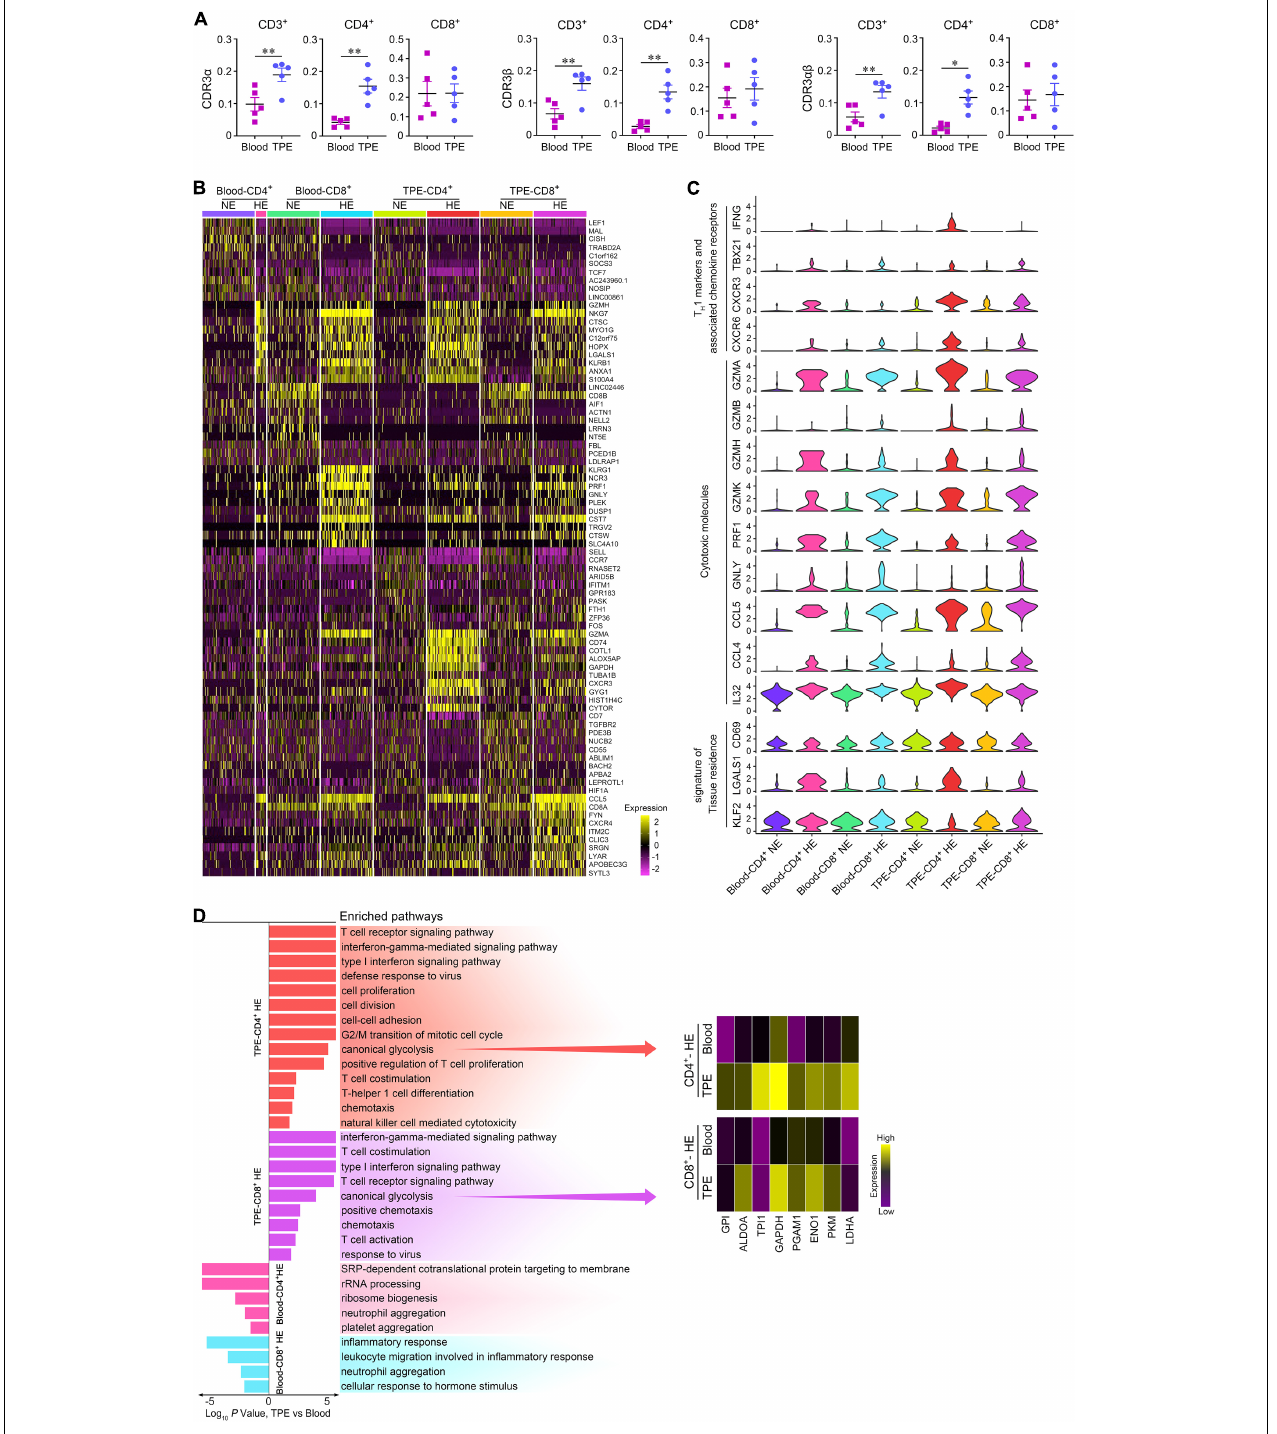
FIGURE 4 | Comparisons of enriched and non-enriched T cell subsets in human TPE and blood. (A) Enriched CDR3 aa clonotype frequency comparisons on CD3 + , CD4 + , and CD8 + T cells between TPE and blood. (B) A heatmap comparing the top 10 differentially expressed genes in each highly enriched and non-enriched T cell subsets in 200 randomly sampled cells per cluster, excluding 39 highly enriched CD4 + T cells in blood. HE, highly enrichment; NE, non-enrichment. (C) Violin plots of expression for select genes in each highly enriched and non-enriched T cell subsets in 200 randomly sampled cells per cluster, excluding 39 highly enriched CD4 + T cells in blood. (D) Pathway enrichment identified immune response pathways for highly enriched T cell subsets between TPE and blood. Data are presented as means ± SEM. * P < 0.05, ** P < 0.01, determined by paired t test. TPE, tuberculous pleural effusion; HE, highly enriched; NE: non-enriched.